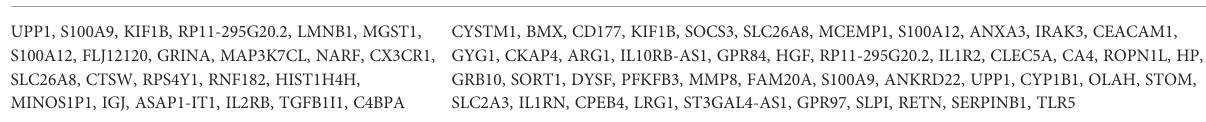
TABLE 1 The key genes screened out through LASSO and random forest analysis. LASSO analysis Random forest